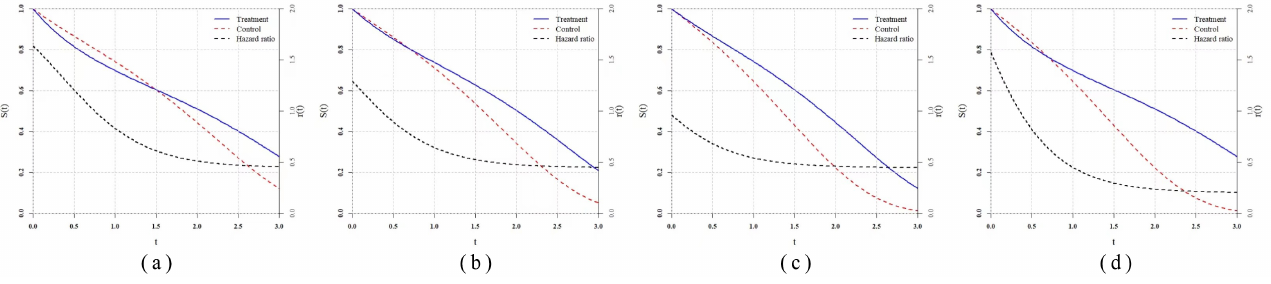
Figure 1. Survival curves with CH function family with parameters settings: ρ = 2, γ = 0.1 ( a ) θ C = − 0.8, θ T = 0 ( b ) θ C = − 0.4, θ T = 0.4 ( c ) θ C = 0, θ T = 0.8 ( d ) θ C = − 0.8, θ T =